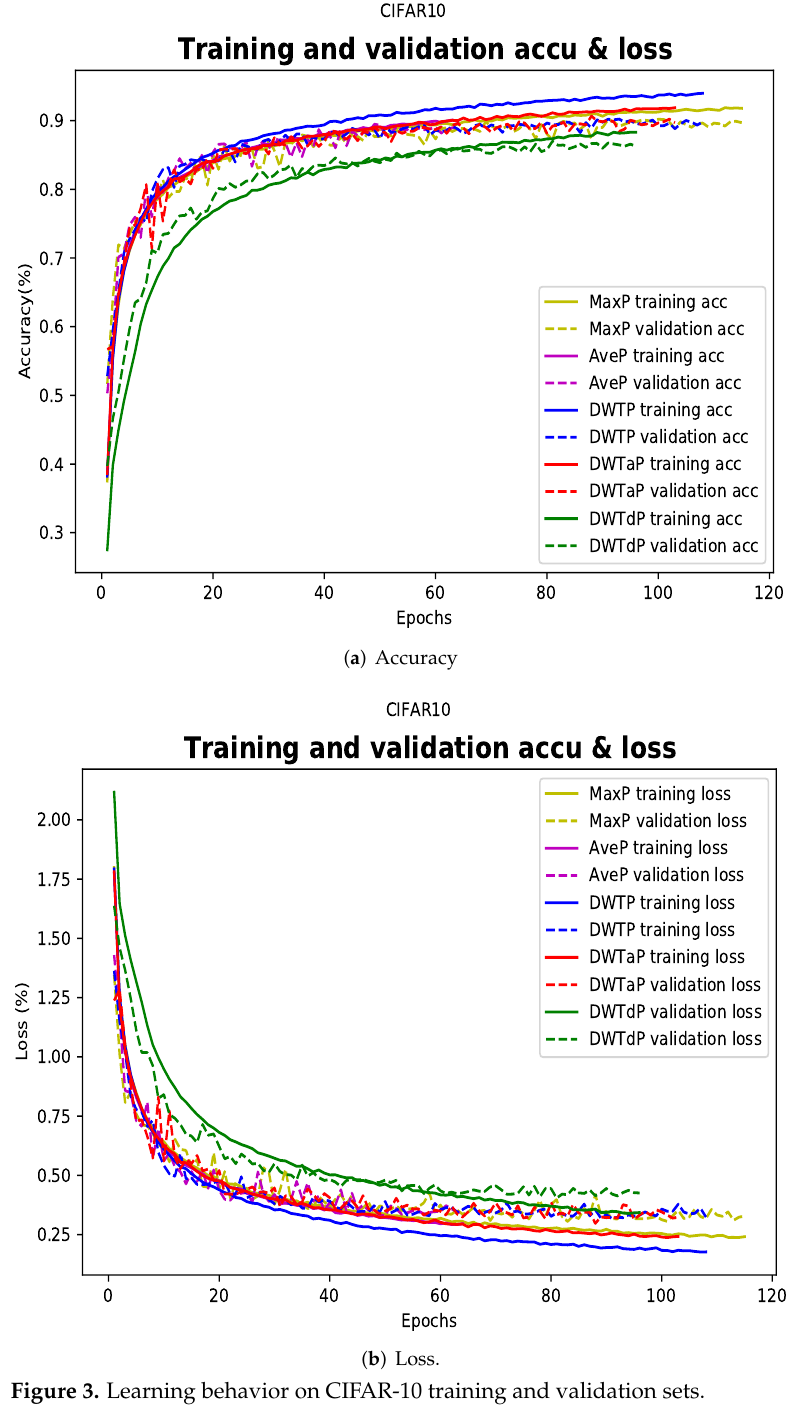
Figure 3. Learning behavior on CIFAR-10 training and validation